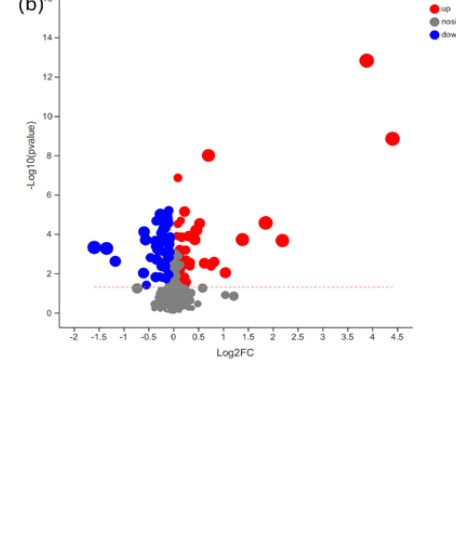
Figure 5. Volcano plots for the potential metabolomic features of muscle samples. ( a ) Volcano plots between CAP-30 and control group; ( b ) CAP-70 and control group; and ( c ) CAP-100 and control